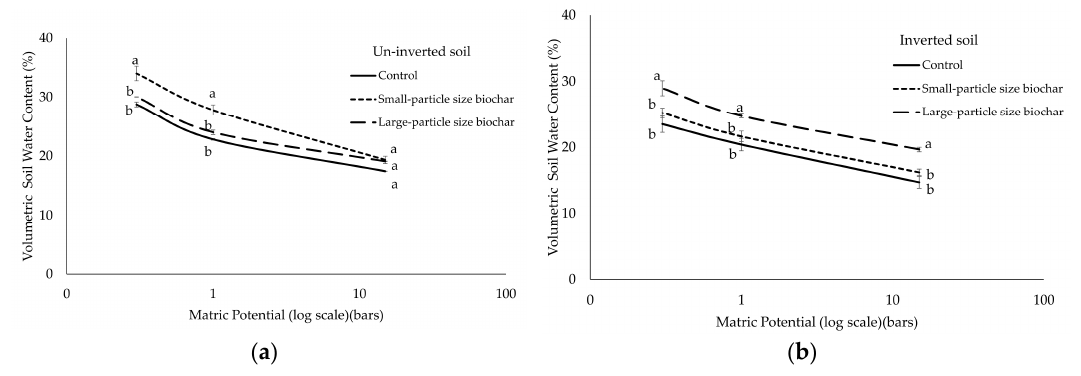
Figure 4. Volumetric soil moisture contents (%) at different matric potentials; − 15, − 1 and − 0.3 bar (in log scale) at ( a ) 6–10 cm depth (un-inverted soil) and ( b ) 10–13 cm depth (inverted soil) measured after the end of the experiment. Within a specific matric potential, different small letters indicate differences at p < 0.10 between treatments (SEM ( n = 4)). In the un-inverted soil, biochar was at 0–10 cm depth; in the inverted soil biochar was at 10–20 cm depth.